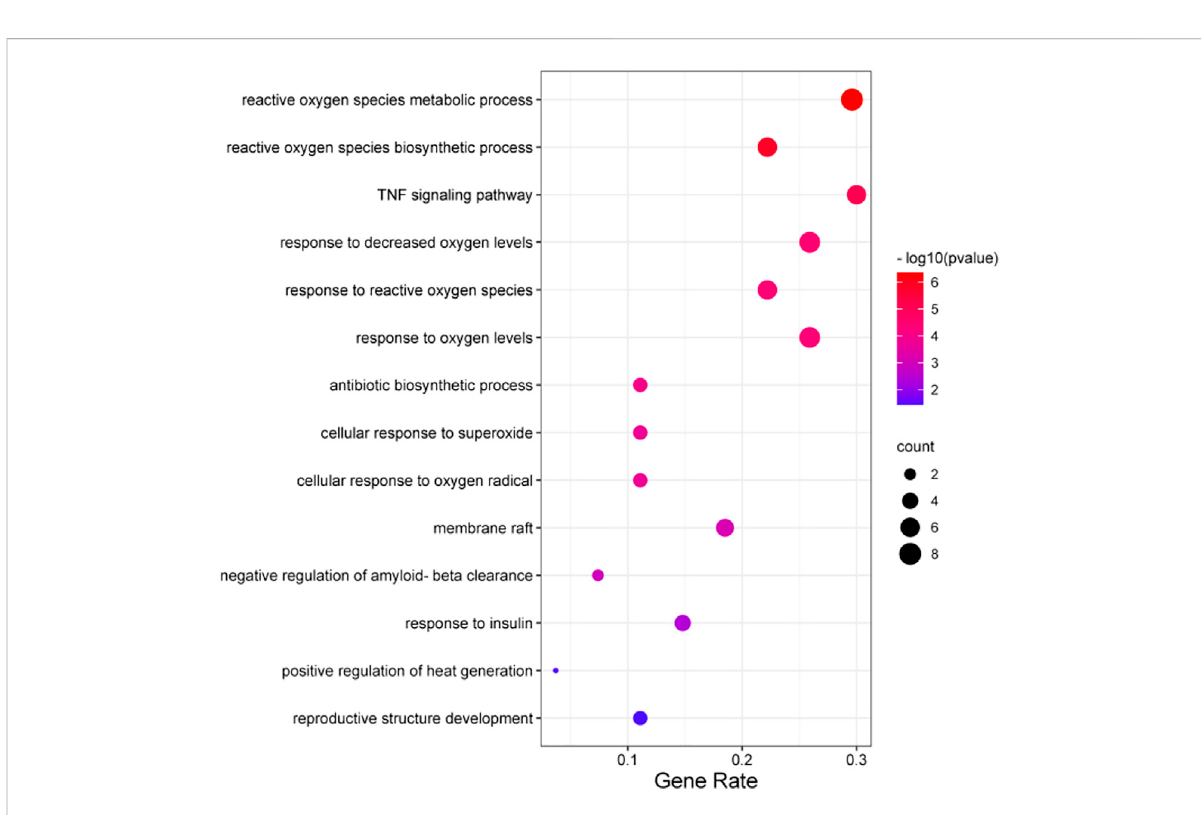
FIGURE 2 KEGG pathway analysis of AOF